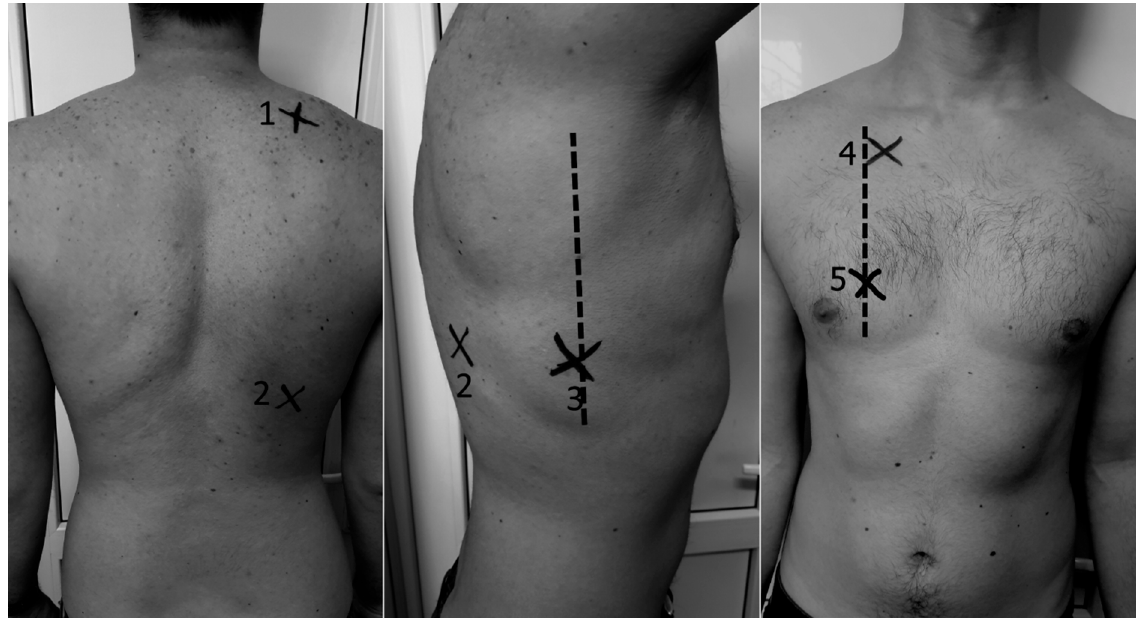
Figure 1. Lung intercostal spaces assessment in a reduced lung ultrasound (LUS) protocol (10 lung intercostal spaces). ( 1 ) Posterior suprascapular intercostal space (IC); ( 2 ) posterior basal subscapular IC (space 5–7); ( 3 ) lateral basal 5–7 IC along midaxillary line; ( 4 ) anterior 2 IC along midclavicular line; ( 5 ) anterior basal 5–7 IC along midclavicular line.